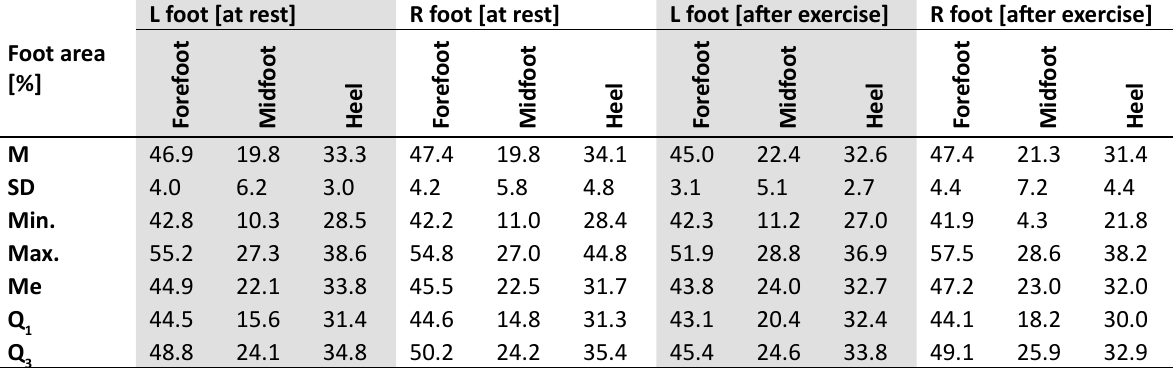
Table 5. Number characteristics of the parameters of foot pressure on the ground amongst the study population of men (n=11)